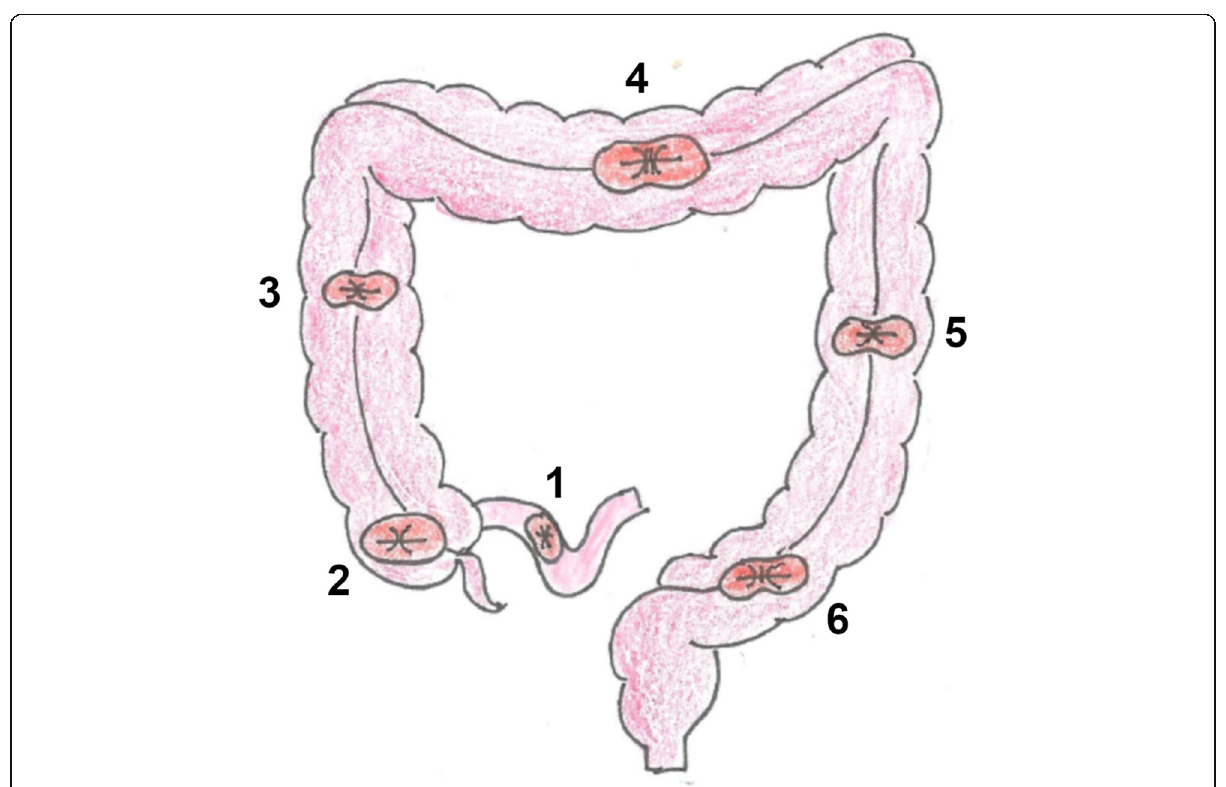
Fig. 1 Sites and names of intestinal stomas. Legend: 1) ileostomy, 2) cecostomy, 3) ascending colostomy, 4) transverse colostomy, 5) descending colostomy, 6) sigmoid